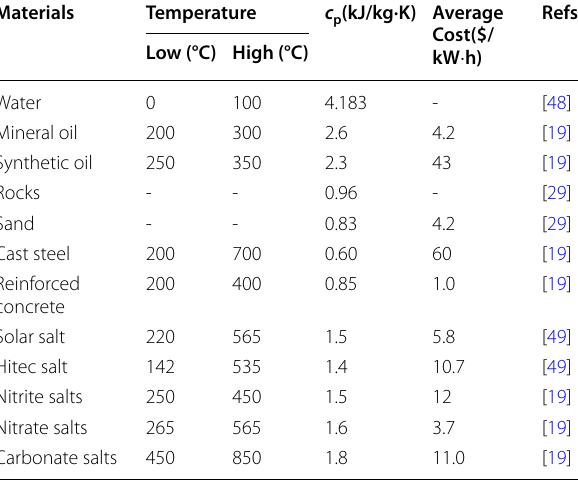
Table 1 Main characteristics of different SHS materials Materials